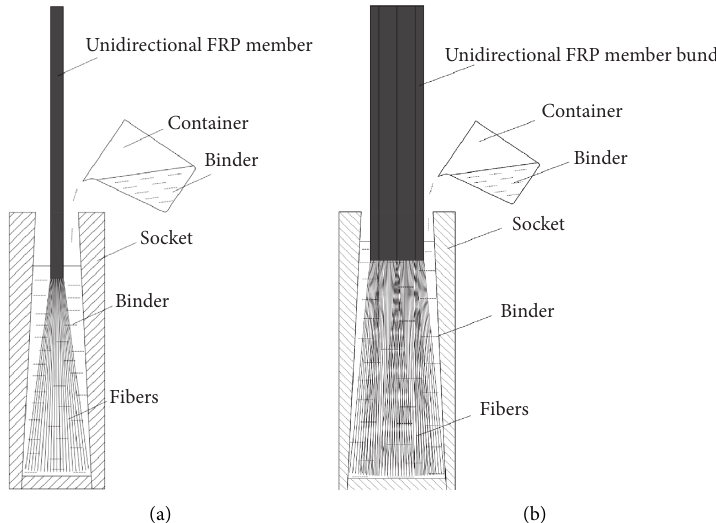
Figure 3: Bonding the fibers of FRP member. (a) Unidirectional FRP member. (b) Unidirectional FRP member bundle.